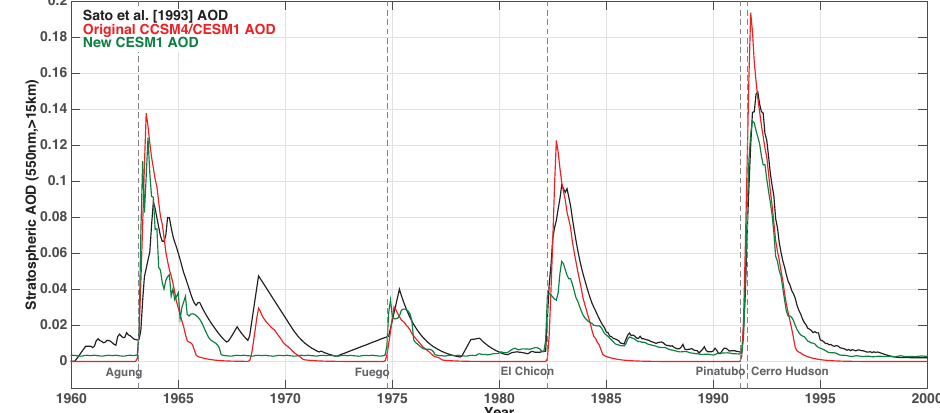
Figure 2. Globally averaged stratospheric AOD at 550nm integrated from 15km and above. The red line represents the AOD as simulated by the original CCSM4/CESM1 simulation configurations. The green line represents the new AOD determined from the SAGE 4 λ forcing file. For comparison, the latest AOD from the Sato et. al. (1993) data set is shown in